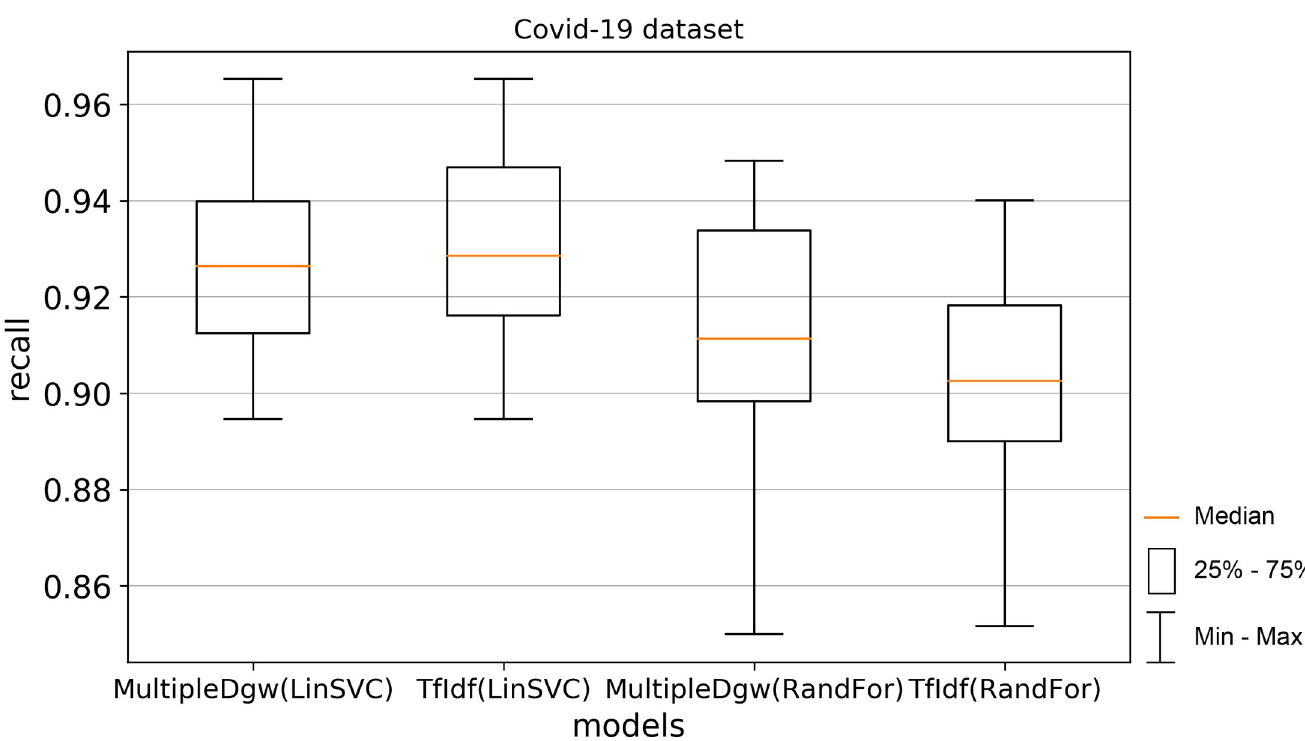
Fig 10. Boxplot for the model performance measurement—recall for dataset Covid-19.